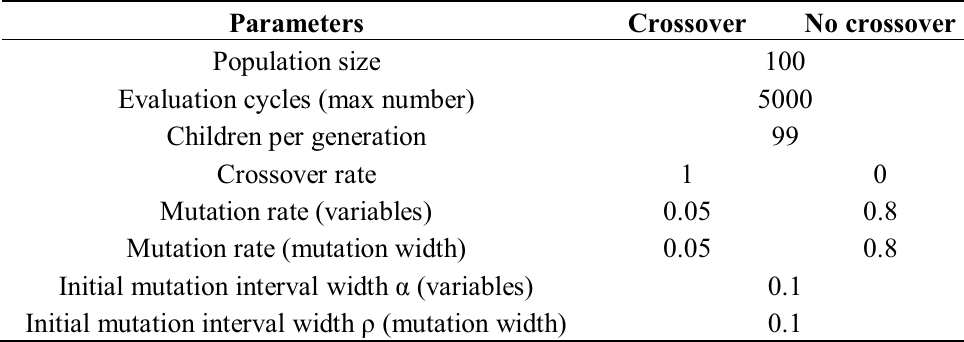
Table 4. The test parameters for the Evolutionary Algorithms (EA) [38].